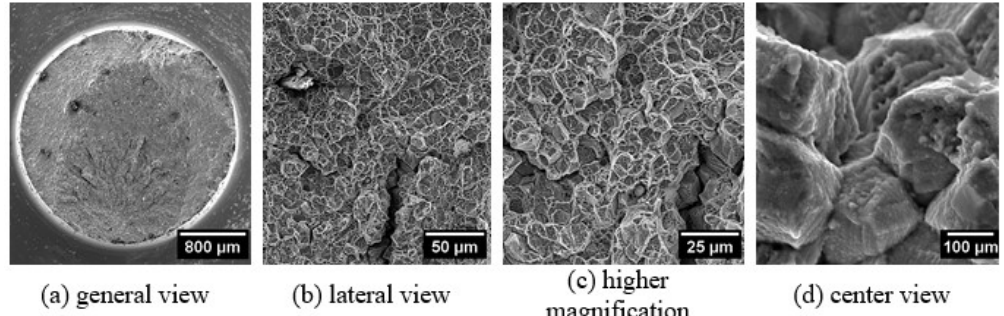
Figure 11. Fracture surface of Inconel 718 after creep test at 675 °C and 700 MPa.